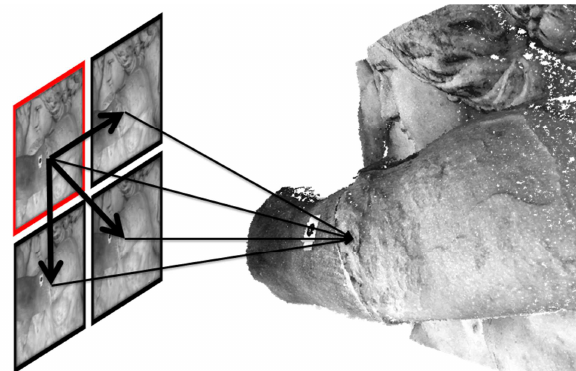
Figure 1: Principle of image based point cloud recording. If images from multiple views are available, corresponding pixels enable the reconstruction of 3D information by intersecting their viewing